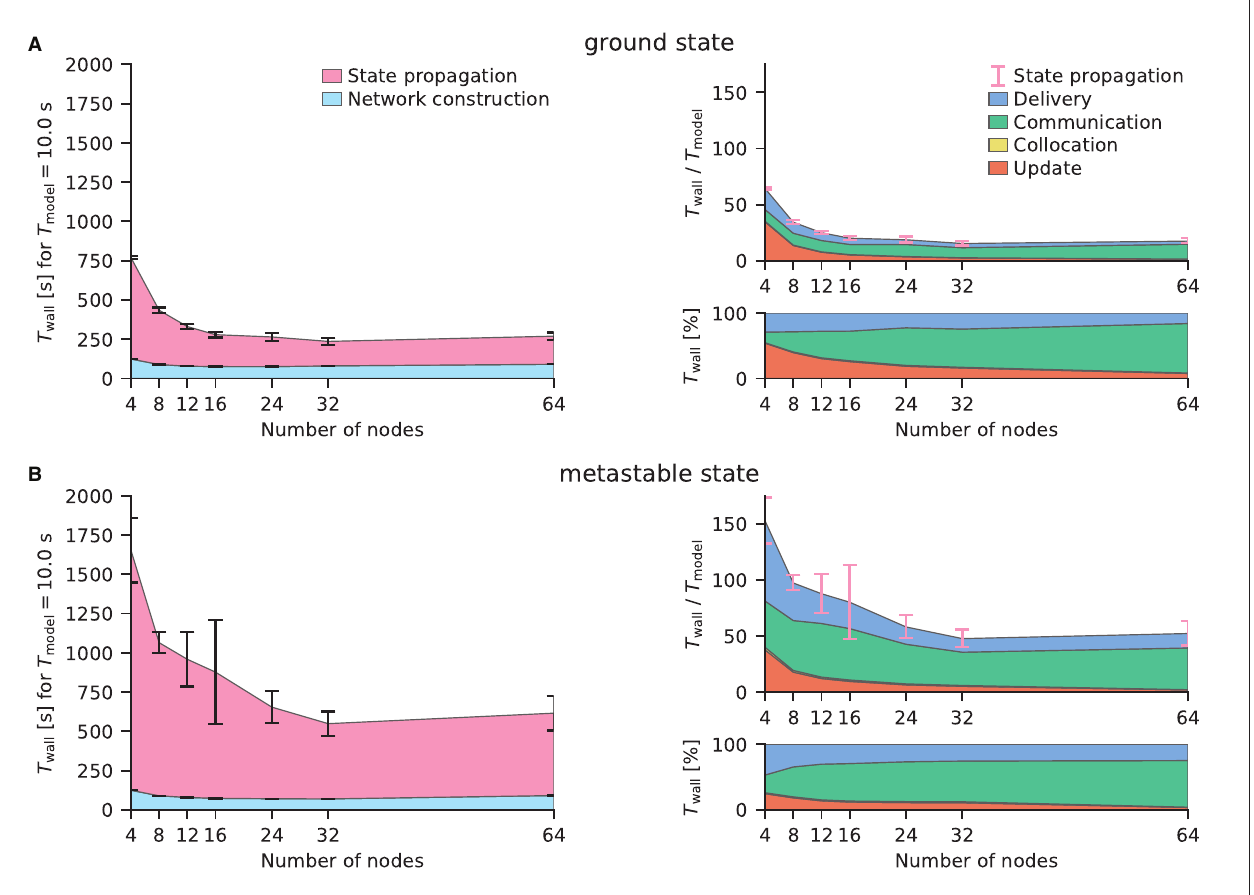
FIGURE 7 | Strong-scaling performance of the multi-area model in its ground and metastable states on JURECA-DC using NEST 3.0. (A) Simulated with parameters inducing stable ground state activity in the network. The left sub-panel displays the absolute wall-clock time T wall for the network construction and state propagation in ms for a biological model time T model = 10s. Error bars indicate the standard deviation of the performance across 10 repeat simulations with different random seeds, the central points of which show the respective mean values. Error bars are shown in pink in the right panels to indicate that they are for the state propagation phase as a whole; the corresponding standard deviations are the same as in the left panels. The top right sub-panel presents the real-time factor defined as T wall / T model . Detailed timers show the absolute (top right) and relative (bottom right) time spent in the four different phases of the state propagation: update, collocation, communication, and delivery. Where the collocation phase is not discernible, this is due to its shortness. (B) Simulated with parameters inducing a metastable state with population bursts of variable duration. Same arrangement as (A)